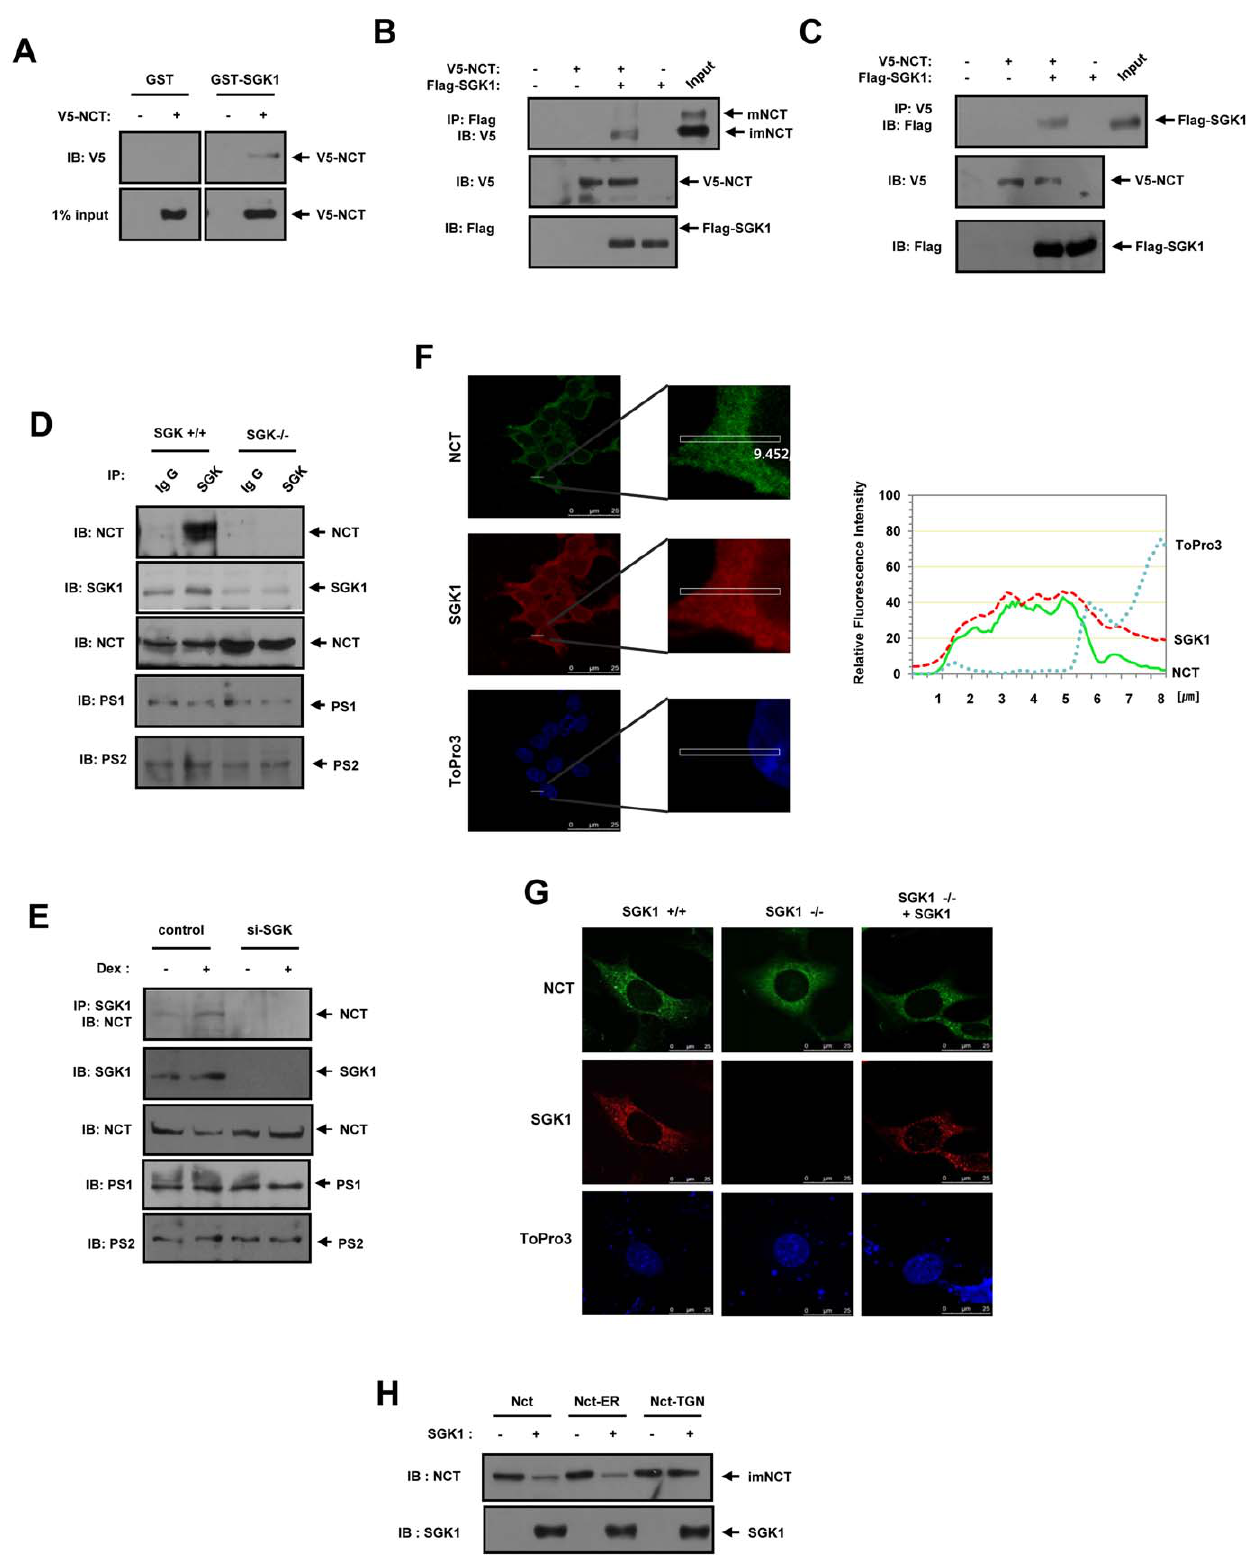
Figure 5. NCT interacts directly with SGK1 in intact cells. (A) Recombinant GST or GST–SGK1 proteins were immobilized onto GSH-agarose. HEK293 cells were transfected with an expression vector encoding for 2 m g of V5-NCT or an empty vector. After 48 hours of transfection, the cell lysates were subjected to GST pull-down experiments with immobilized GST or GST–SGK1. Proteins bound to GST or GST–SGK1 was analyzed via immunoblotting with an anti-V5 antibody. The input represents 1% of the cell lysate prior to in vitro binding assay. (B, C) HEK293 cells were